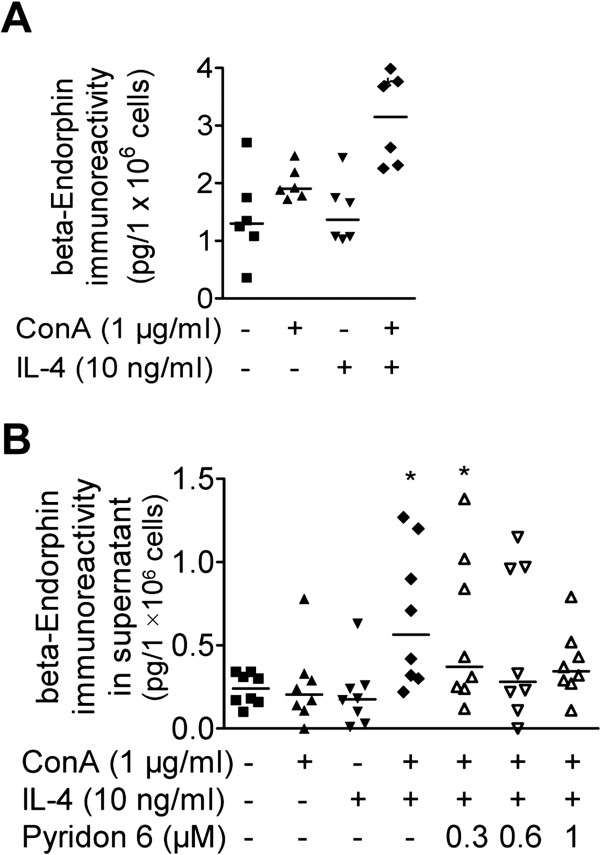
Cellular levels of beta-endorphin immunoreactivity increase in ConA-activated and IL-4-stimulated lymphocytes.A) 24 h after cell stimulation with/without IL-4 (10 ng/ml) and ConA (1 μg/ml), beta-endorphin immunoreactivity was determined in cell lysates. Data represent the beta-endorphin immunoreactivity in pg/1.0E+06 cells of n = 6 independent experiments; median is indicated by the horizontal line. B) Ionomycin-induced release of immunoreactive beta-endorphin was determined using EIA in the supernatant of cells stimulated for 24 h with/without IL-4 (10 ng/ml), ConA (1 μg/ml), and pretreated with pyridon 6 at the indicated doses. Data represent the beta-endorphin immunoreactivities in pg/1.0E+06 cells of n = 8 independent experiments; median is indicated by the horizontal line. All data were analyzed using Friedmann and Dunn’s Test in comparison to unstimulated controls (*P < 0.05).